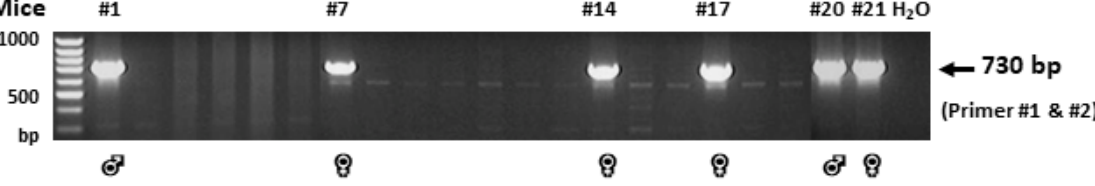
Figure 1. Generation of transgenic mice carrying the inducible Puf-A shRNA construct. ( A ) Schematic presentation of the construct used to generate inducible Puf-A shRNA transgenic mice. The complementary Puf-A shRNA oligonucleotides were inserted into the plasmid PGK-tTS-TRE. The fragment of the Puf-A shRNA transgene was in the region between EcoRV and HindIII. Primers #1 and #2 were used for detection in C57BL/6J mice that were positive for the inducible Puf-A shRNA transgene (730 bp). Primers #3 and #4 were used for real-time qPCR from genomic DNA of the transgenic mice to determine the zygosity of the mice with Puf-A shRNA. ( B ): Genotyping of the 21 mice injected with Puf-A shRNA transgene used primers #1 and #2 (Figure 1A) in the PCR reaction. Amplification of Puf-A shRNA transgene (arrows, 730 bp) was detected in mice #1 ( ♂ ), 7 ( ♀ ), 14 ( ♀ ), 17 ( ♀ ), 20 ( ♂ ) and 21 ( ♀ ). Distilled water was used as the negative control.